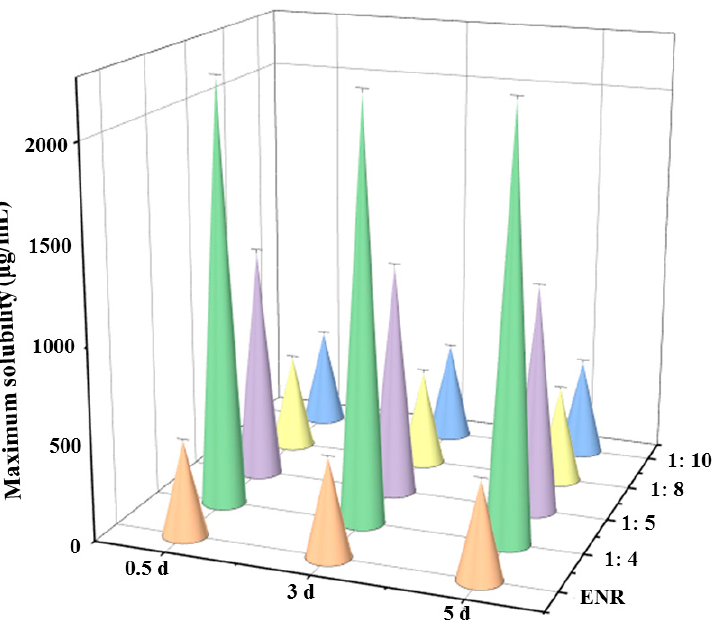
Figure 4. The solubility of ENR and different ENR-SDs (38.5 °C, pH = 6.8). The saturated solubility of ENR was enhanced 2.35-fold by ENR-SD (weight ratio 1:5). Note: ENR, native enrofloxacin, 1:4,